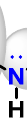
Figure 1. The functional diversity of the hydrazone skeleton.